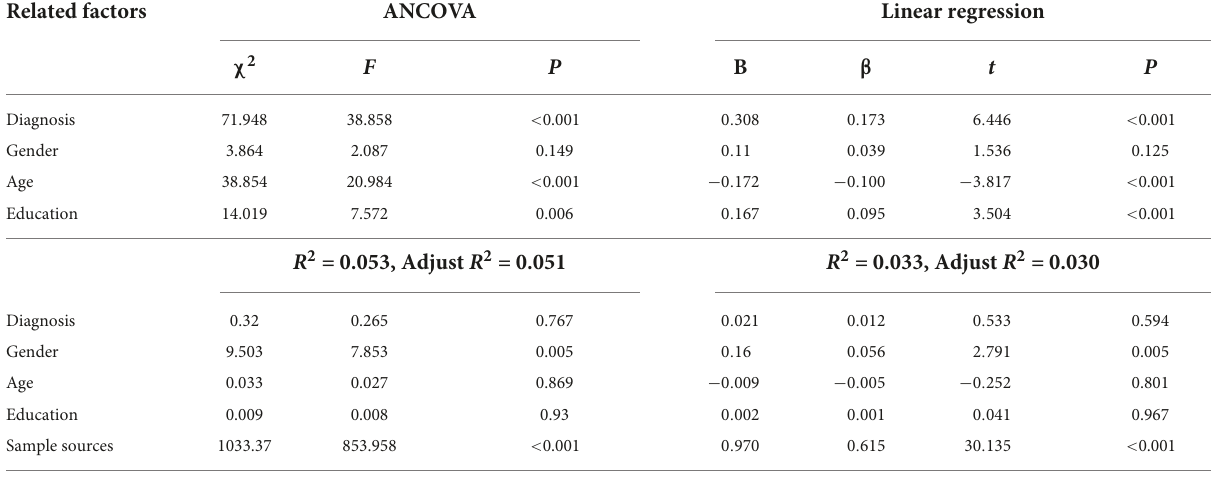
TABLE 5 The comprehensive effects of diagnosis, gender, age, education and sample source on brain-derived neurotrophic factor. Related